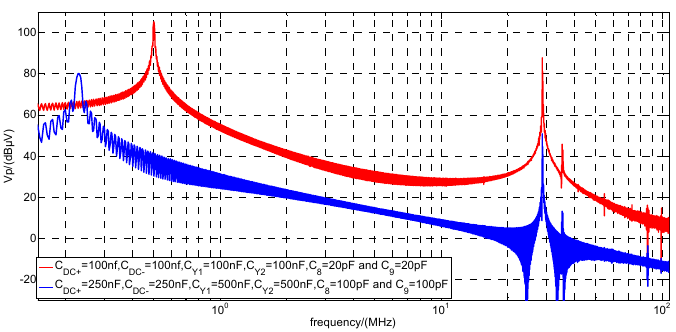
Figure 18. Positive CE voltage after C DC+ , C DC − , C Y1 , C Y2 , C 8 and C 9 were increased.